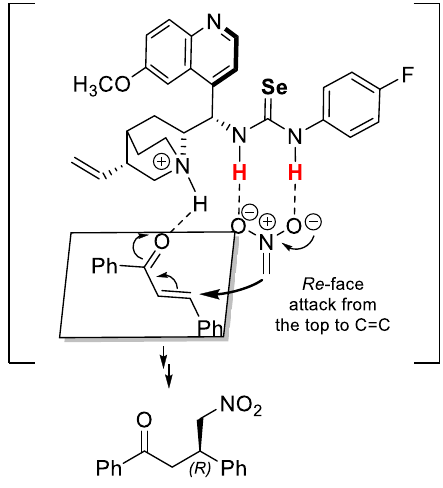
Figure 2. A proposed transition state.